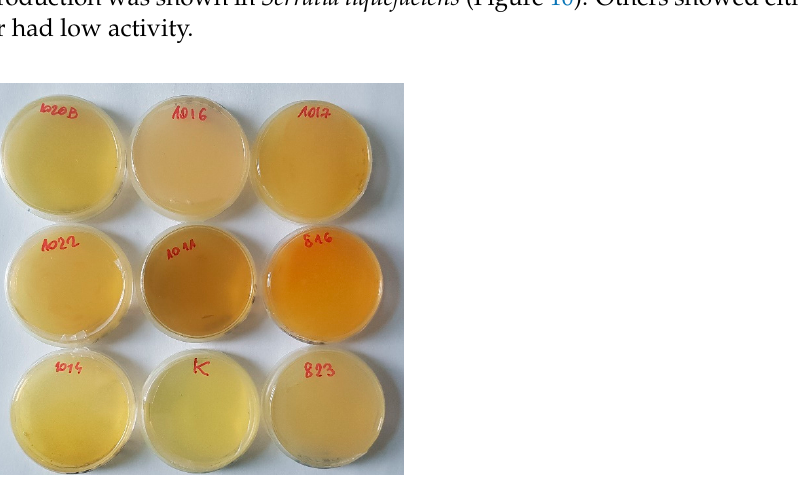
Figure 9. Rotifers treated with chitinase: ( A ) swimming rotifers before treatment; ( B ) immobilized rotifers with mastax inside, directly after treatment; ( C ) after 24 h; few remain alive and most strongly changed, without visible internal structures, but still swimming; magnification 100×.